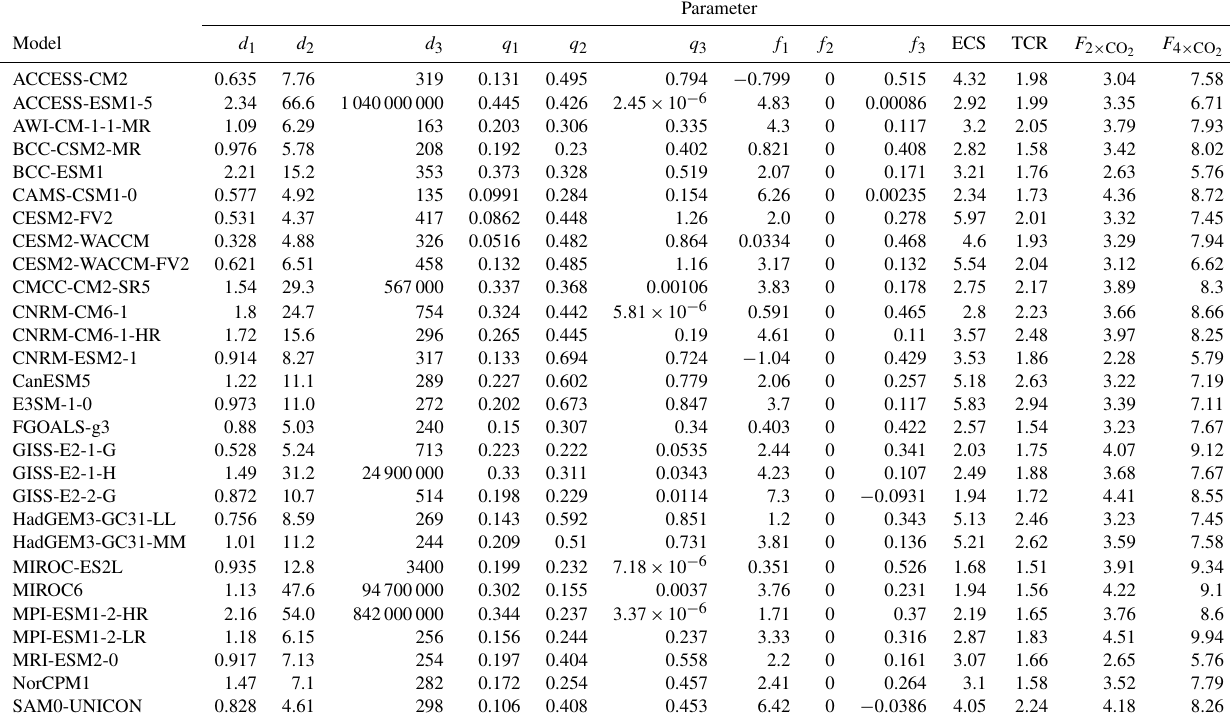
Table 2. Tuned CMIP6 thermal response parameters.